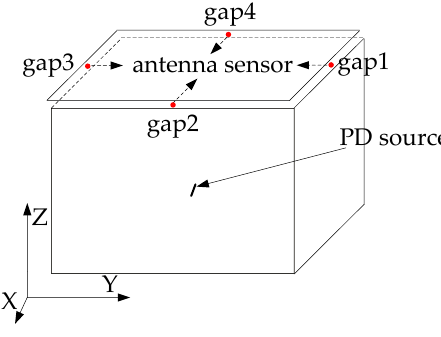
Figure 11. Each gap of the transformer has an antenna sensor.